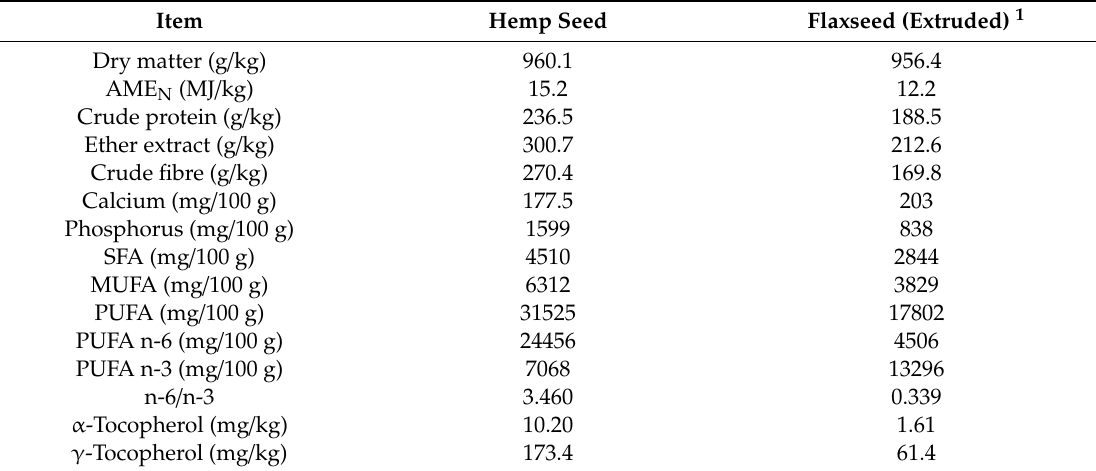
Table 1. Nutrient composition of hemp seed and extruded flaxseed.